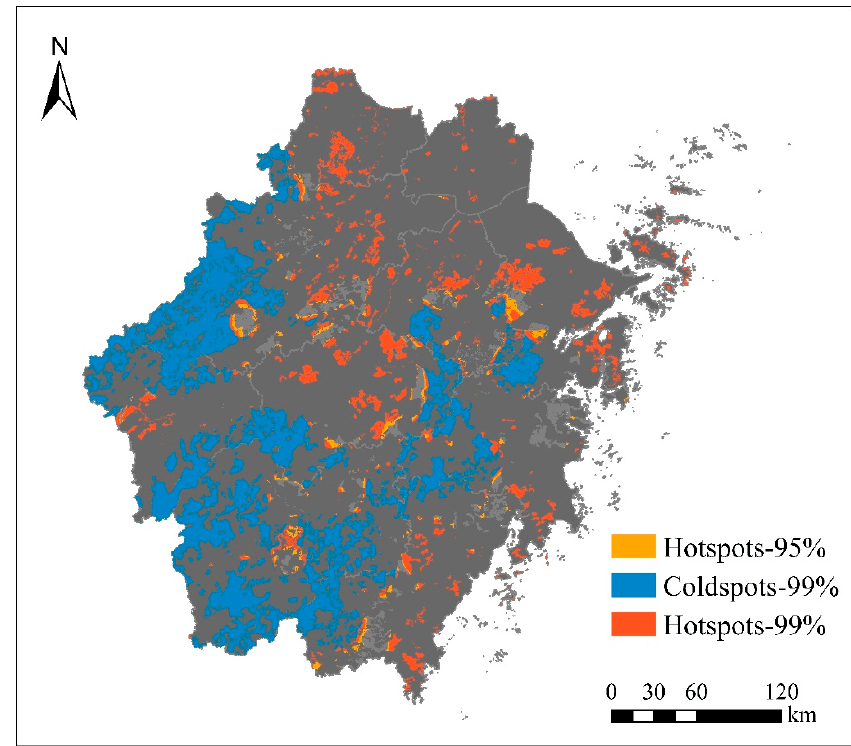
Figure 7. Hotspots and cold spots of the study area in 2019. Table 1. The area and ALAN statistics of hotspots and cold